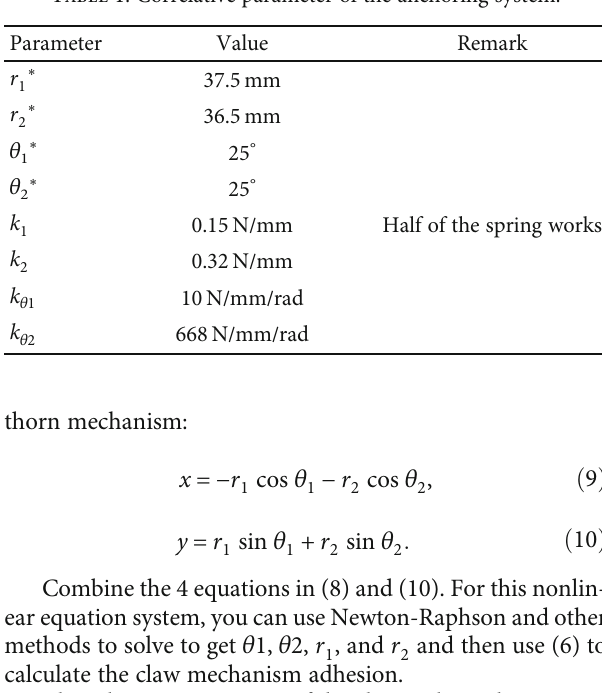
Table 1: Correlative parameter of the anchoring